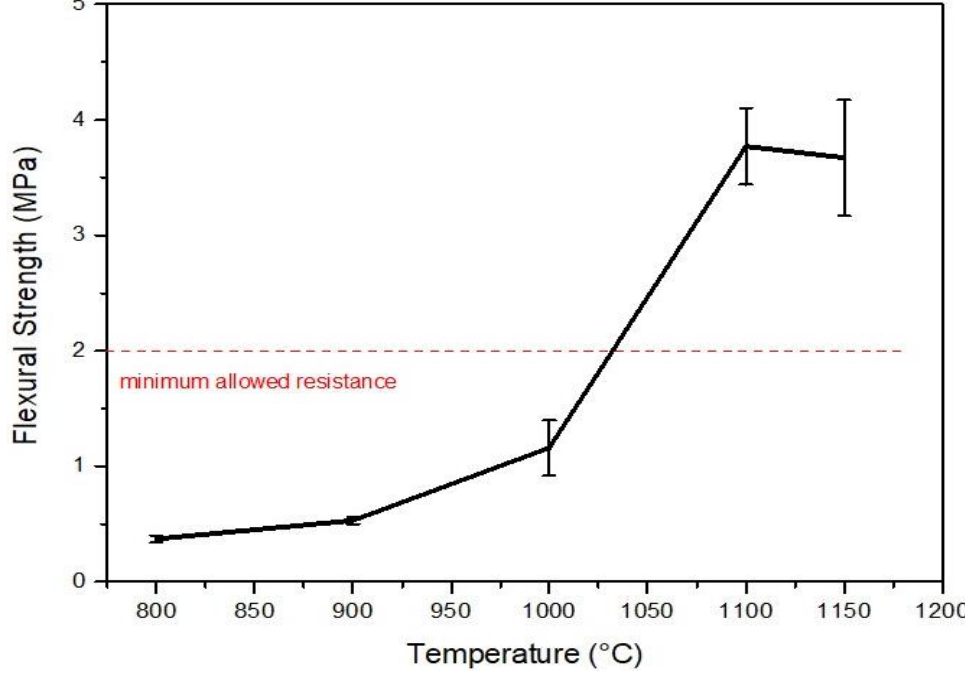
Figure 10. Results of the flexural strength test.